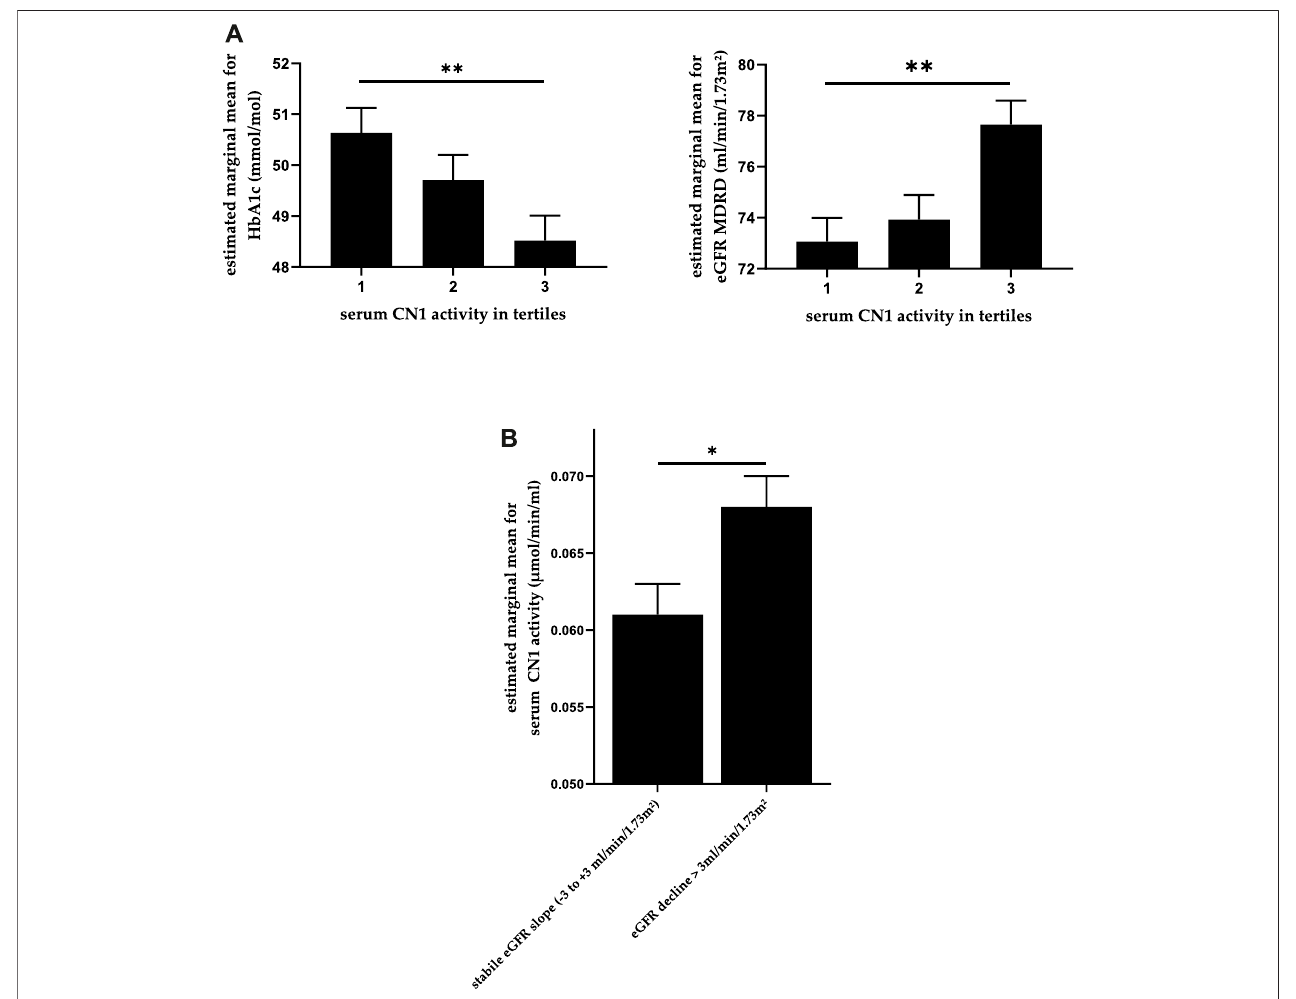
FIGURE 1 | (A) Association between CN1 activity and both HbA1c and eGFR whilst controlling for age and gender. The estimated means are depicted in the picturewithstandarderror. (B) CN1 activity inpatientswithaneGFR decline > 3 ml/min/1.73 m 2 per anno compared tothose withstable eGFRwhilstcontrollingforage and gender. One-way ANCOVA, p -values adjusted using Bonferroni method. * for p < 0.05 and ** for p < 0.01.